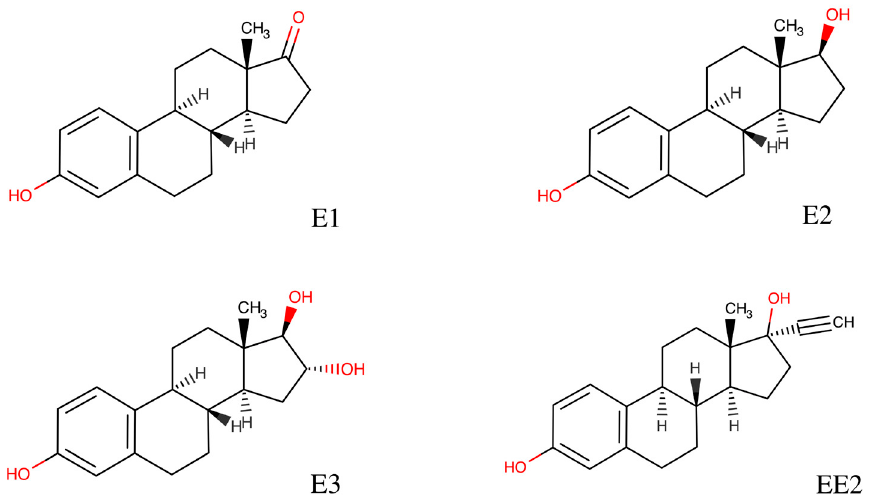
Figure 1. Chemical structure of selected estrogens.